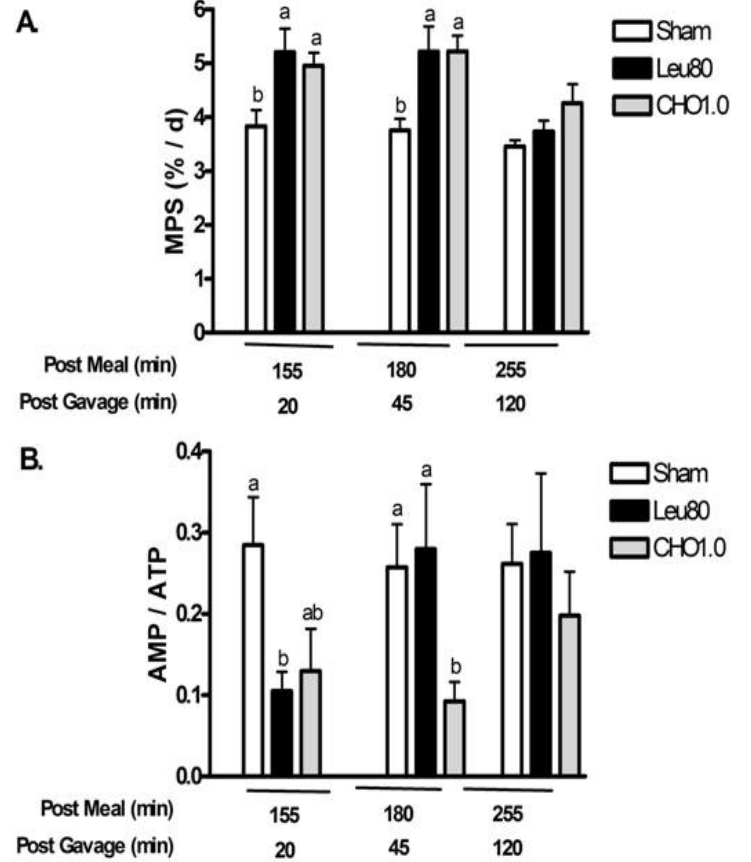
Figure 4. Postprandial changes for muscle protein synthesis (MPS) and AMP/ATP for experiment 2. Values are mean ± S.E.M., n = 5–8 per group. Rats were gavaged with water (Sham), 80 mg leucine, 40 mg isoleucine, and 40 mg valine (Leu80), or 1 g carbohydrates (CHO1.0). Panel A shows changes in muscle protein synthesis (MPS); Panel B shows changes in AMP / ATP. Two-way ANOVA P < 0.05 indicated significant main effects for treatment and time, with a significant interaction ( P < 0.05). Means not sharing a common letter are different within time-points ( P < 0.05, LSD post hoc